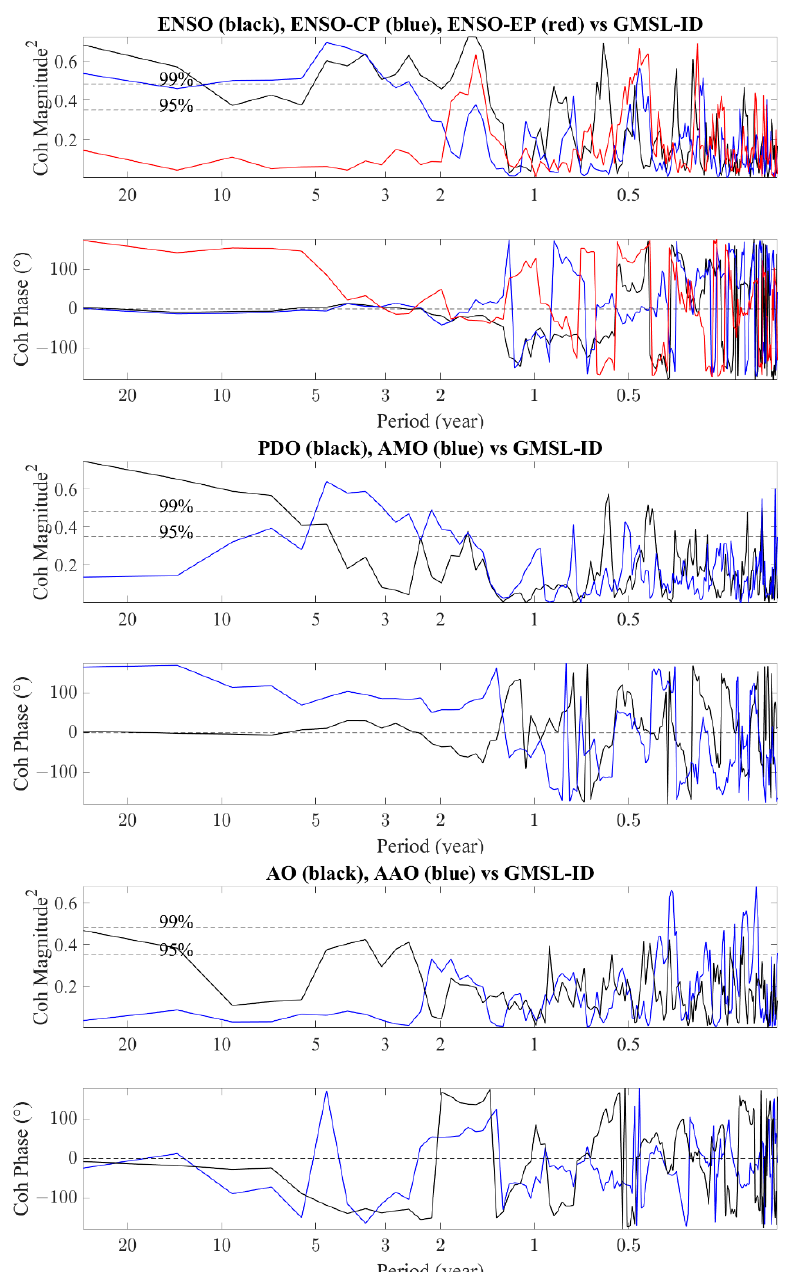
Figure 4. The frequency-domain cross-coherence spectra (magnitude squares and phase) of GMSL- ID ( t ) with respect to the indices of the five climatic oscillations in Figure 2 as a function of period (in years), where positive phase means GMSL-ID ( t ) leading ( a ) ENSO (black), ENSO-CP (blue), and ENSO-EP (red); ( b ) PDO (black) and AMO (blue); ( c ) AAO (black) and AO (blue). The dashed horizontal lines indicate the statistical confidence levels.